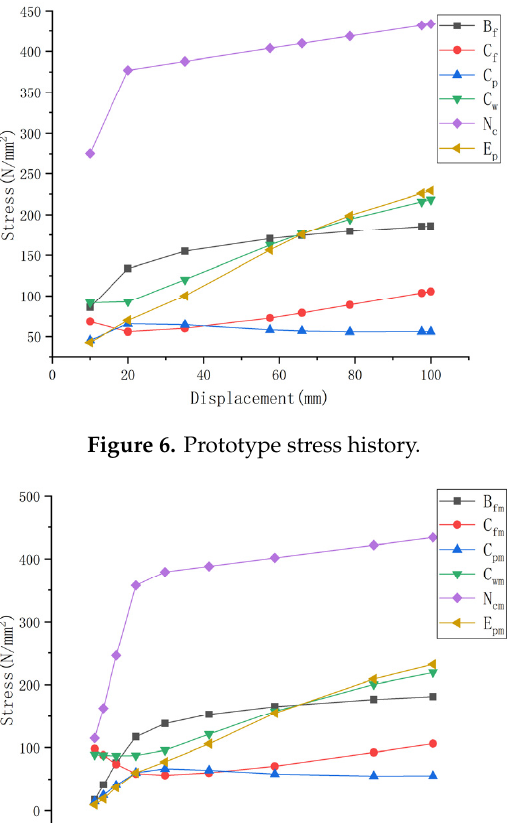
Figure 7. Model stress history.